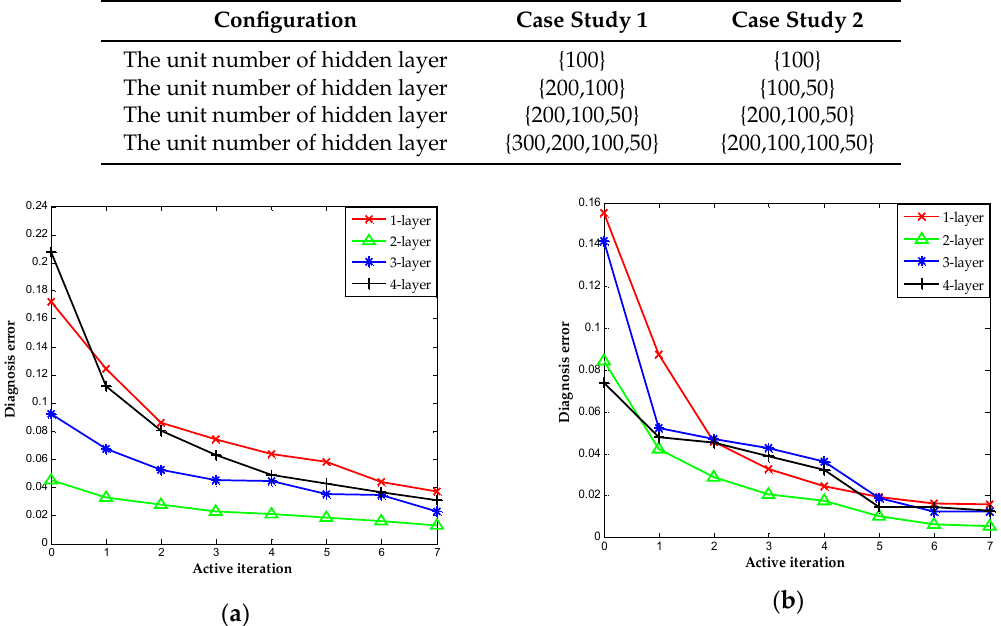
Table 4. The parameters of hidden layer.